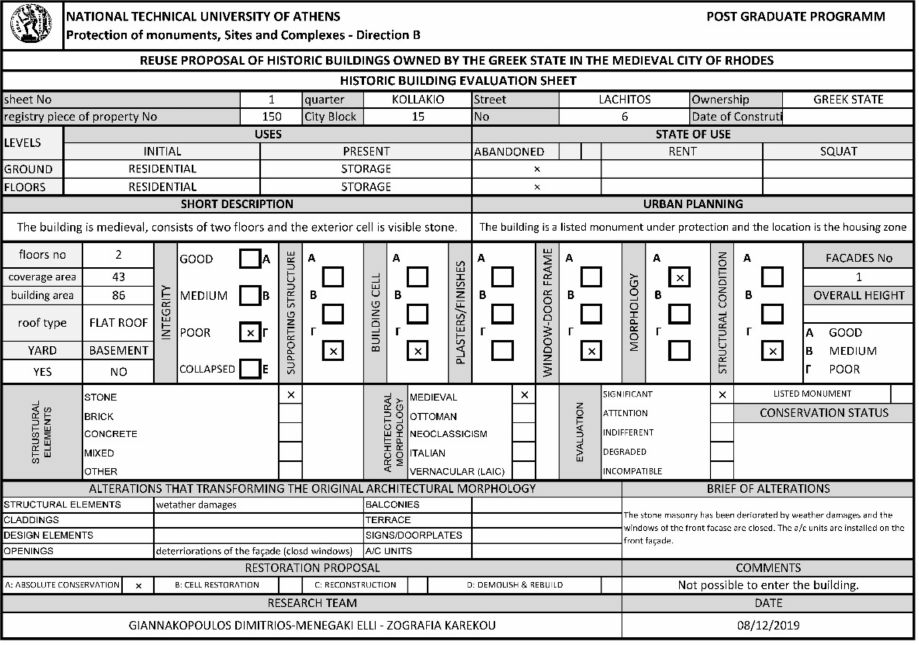
Figure 11. Example of an evaluation sheet of selected buildings: front page—short description.